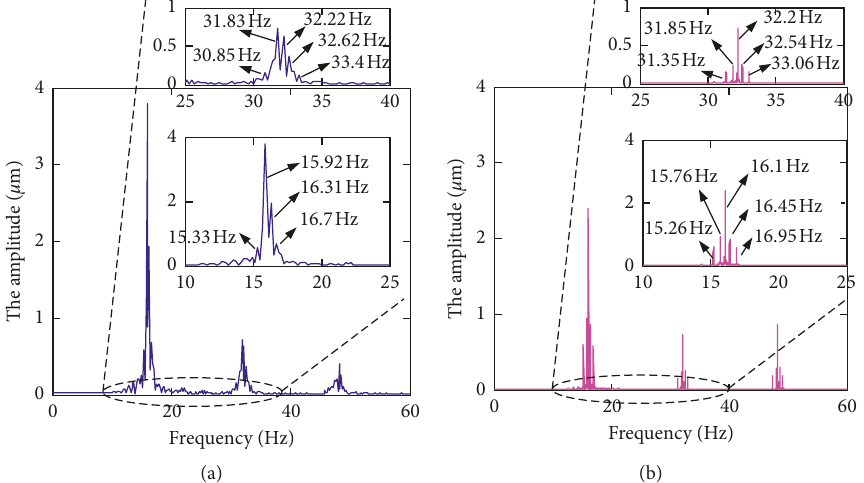
Figure 21: Spectrum and partial enlarged view of gear frequency component of quasistatic transmission error: (a) experiment; (b) simulation by using the proposed